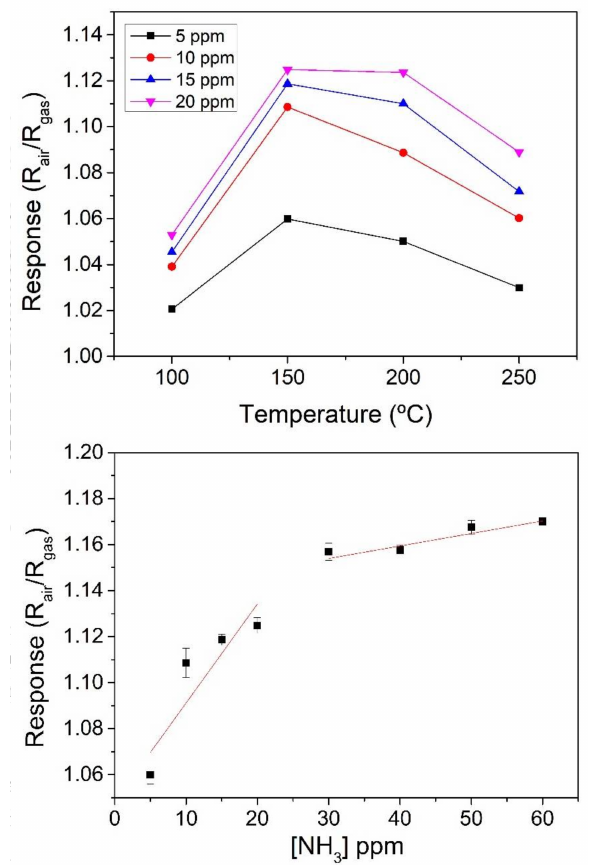
Figure 5. Effect of the operating temperature on the response towards different concentrations of NH 3 ( upper panel ). Calibration curve towards NH 3 for a sensor operated at the optimal working temperature of 150 ◦ C ( lower panel